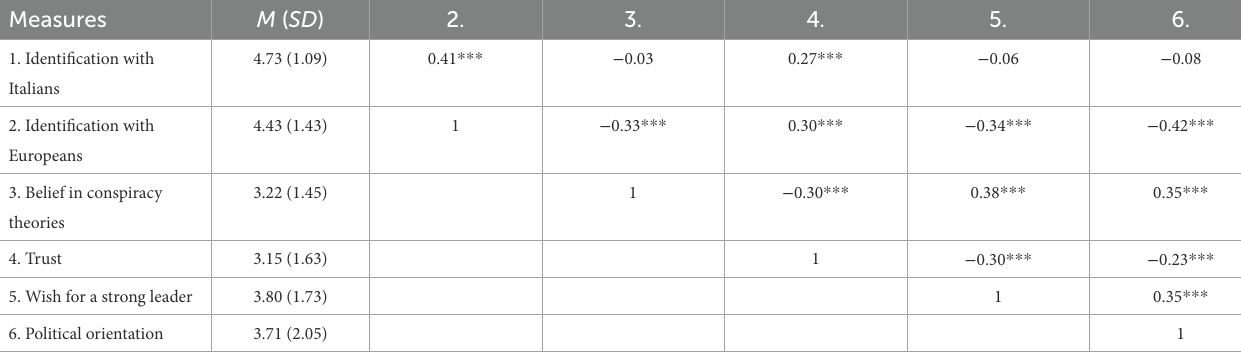
TABLE 1 Means (standard deviations) of the model variables and correlation matrix.